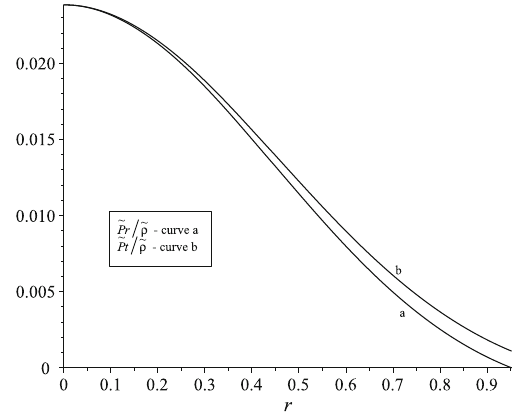
the first method throws a solution that does not satisfy the conditions for physical